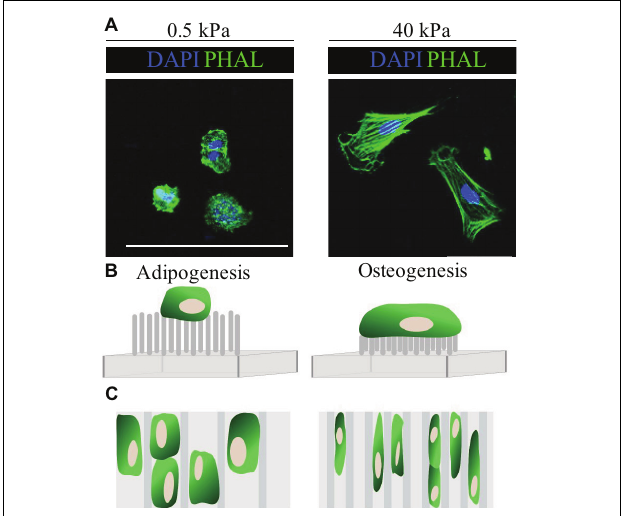
FIGURE 2 | Summary of cell responses to ECM elasticity, topography and micropillars. (A) Fluorescence microscopy images show typical cell response on soft (0.5 kPa) and stiff (40 kPa) substrates. In general, cells (in this case embryonic neural crest cells) on soft (0.5 kPa) substrates remain rounded, whilst those on stiff (40 kPa) ECM spread and have organised F-actin fibres, as seen by the phalloidin staining (PHAL, green). (B) Typically, MSC cultured on long flexible micropillars respond similarly as they would on soft ECM and have a rounded morphology, whilst those on short inflexible micropillars behave as they would on stiff ECM and spread. (C) In general, MSC cultured on wider microgrooves show enhanced adipogenesis, whilst those on stiff substrates have an elongated morphology which promotes osteogenesis (Fu et al., 2010; Nikkhah et al., 2012; Abagnale et al., 2015). Scale bar 100 µ